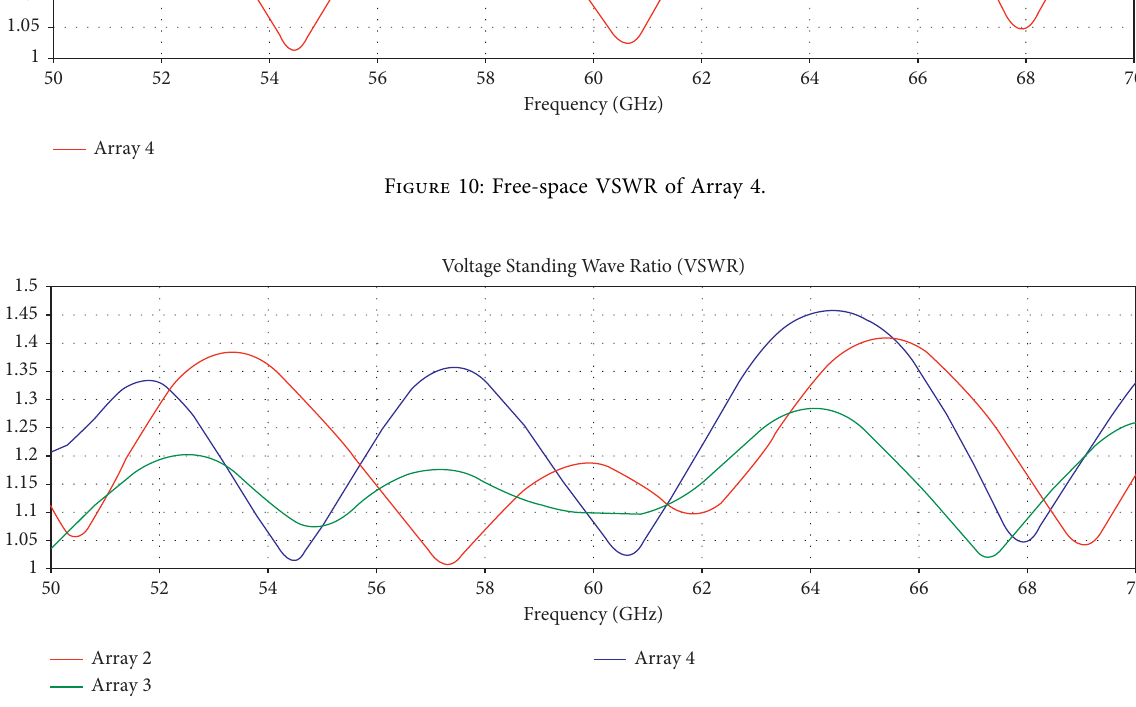
Figure 11: Free-space VSWR comparison.